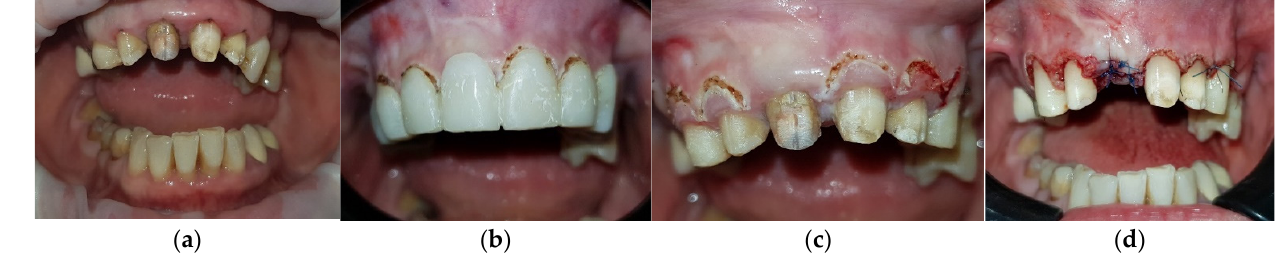
Figure 5. The steps of the crown-lengthening surgery: ( a ) The abutments after the removal of the old restorations and a preliminary preparation before the surgery; ( b ) Predefinition of the gingival margins using the surgical guide and the Lasotronix Smart M Pro laser; ( c ) The limits of the new gingival margins after the removal of the surgical guide; ( d ) The aspect of the prosthodontic field after the piezo and laser surgery.